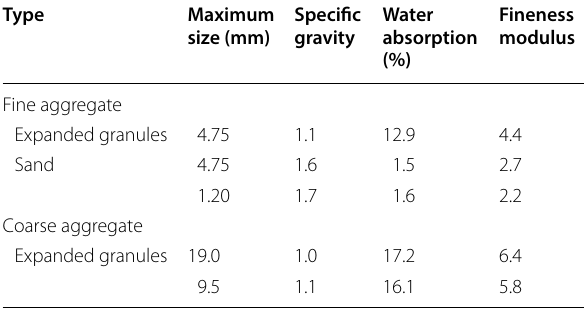
Table 2 Properties of the aggregates